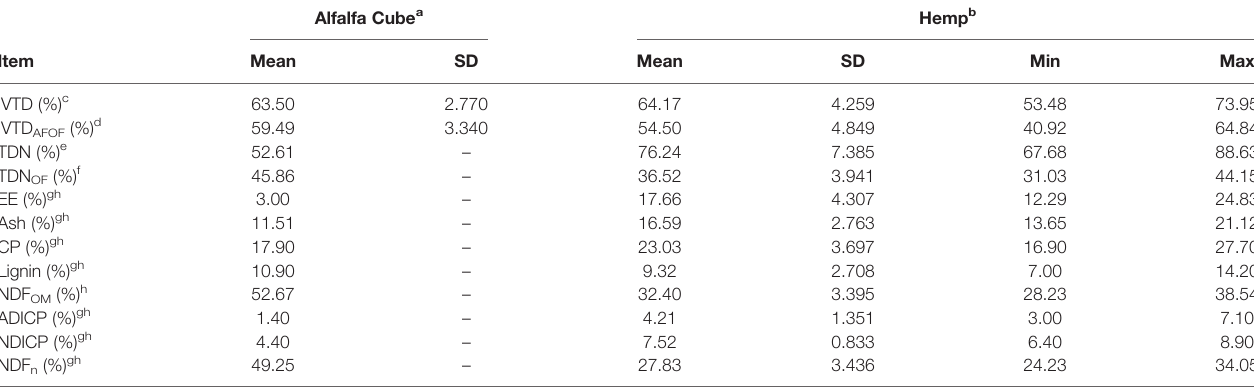
TABLE 3 | Descriptive statistics for digestibility and nutrient concentrations of ground alfalfa cube and in fl orescence from 9 non-extracted hemp